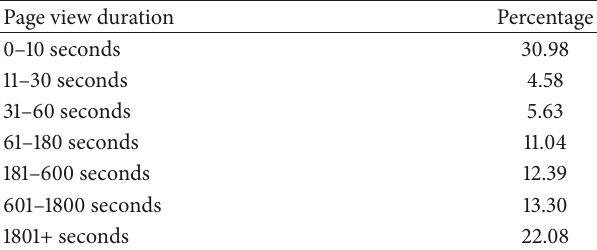
Table 4: Duration of multiproduct page